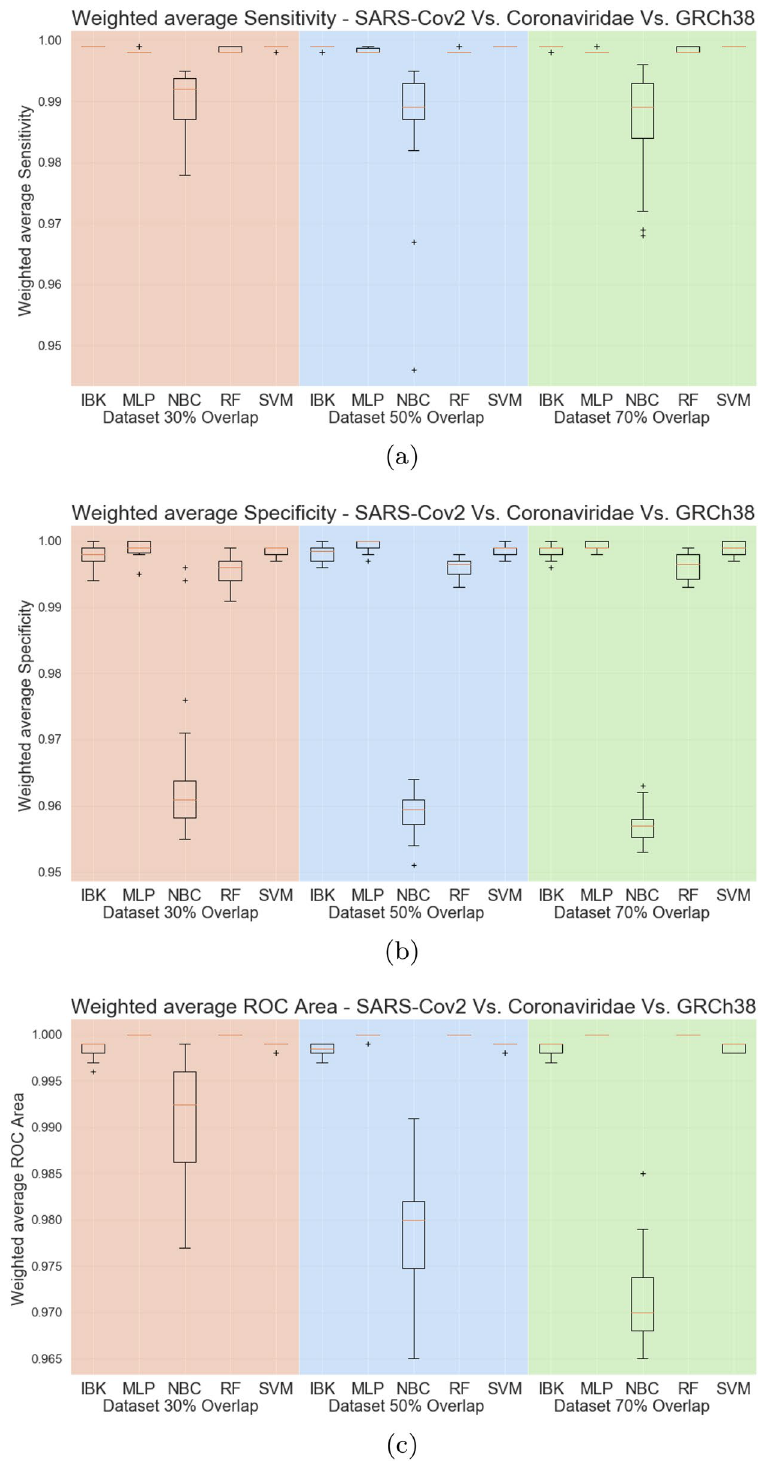
Figure 18. Weighted average sensitivity ( a ), specificity ( b ), and ROC area for SARS-CoV-2 test